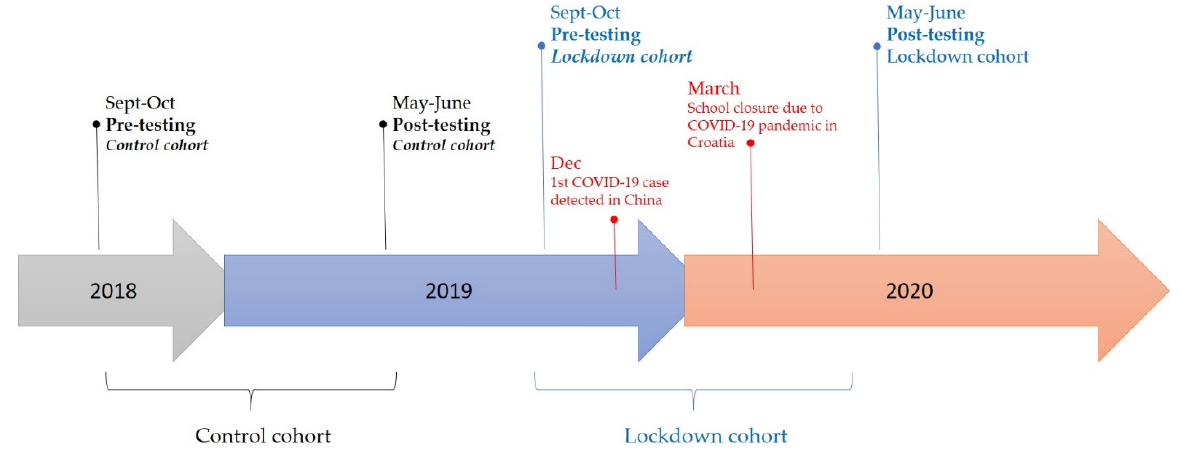
Figure 1. Timeline and design of the study.